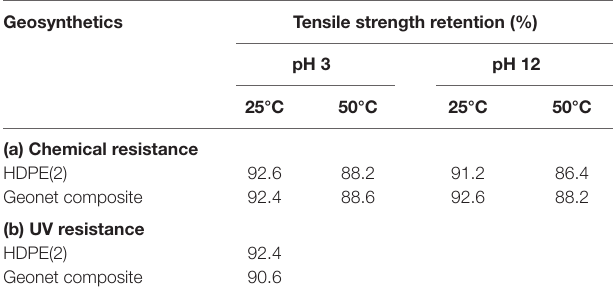
TaBle 2 | Tensile strength retentions of separation box plate and geonet